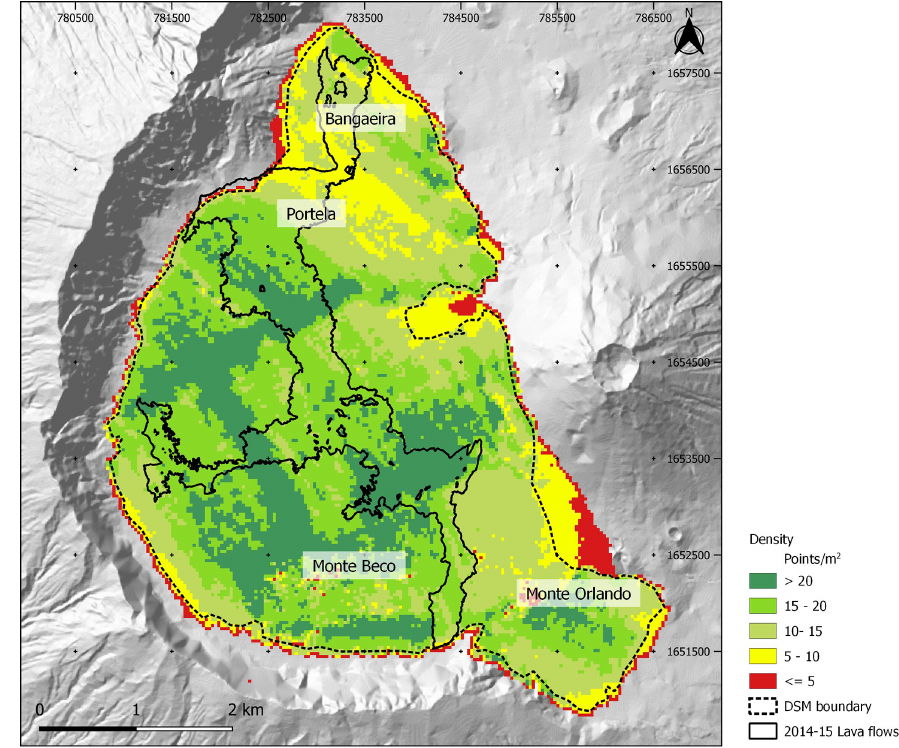
Figure 9. Density of the point cloud of Chã das Caldeiras.